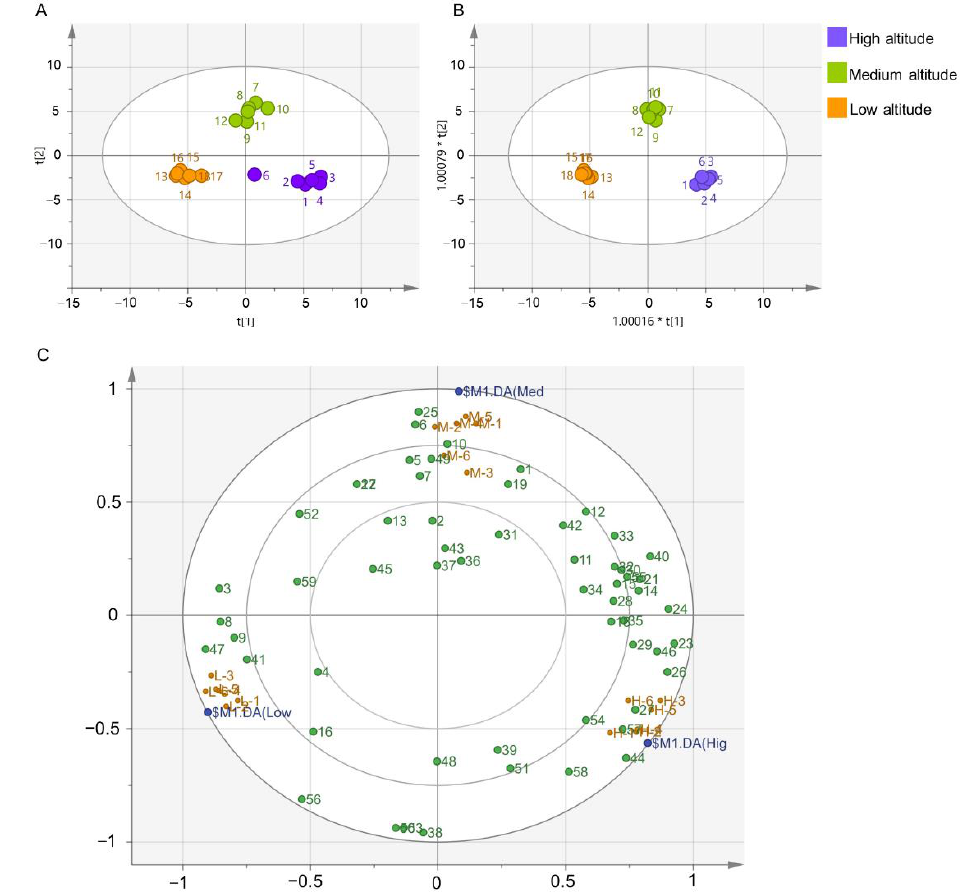
Figure 3. Multivariate chemometric analysis of Lingtou Dancong oolong tea product from different altitudes. ( A ) PCA score plot; ( B ) OPLS-DA score plot; ( C ) Loading plot. The horizontal axis represents PC1, and the vertical axis represents PC2. Hig, high altitude, Med, medium altitude, Low, low altitude. Compounds numbered in ( C ) were correspond to Table 1. High altitude, medium altitude and low altitude represent the Lingtou Dancong oolong teas from high, medium and low altitude, respectively.